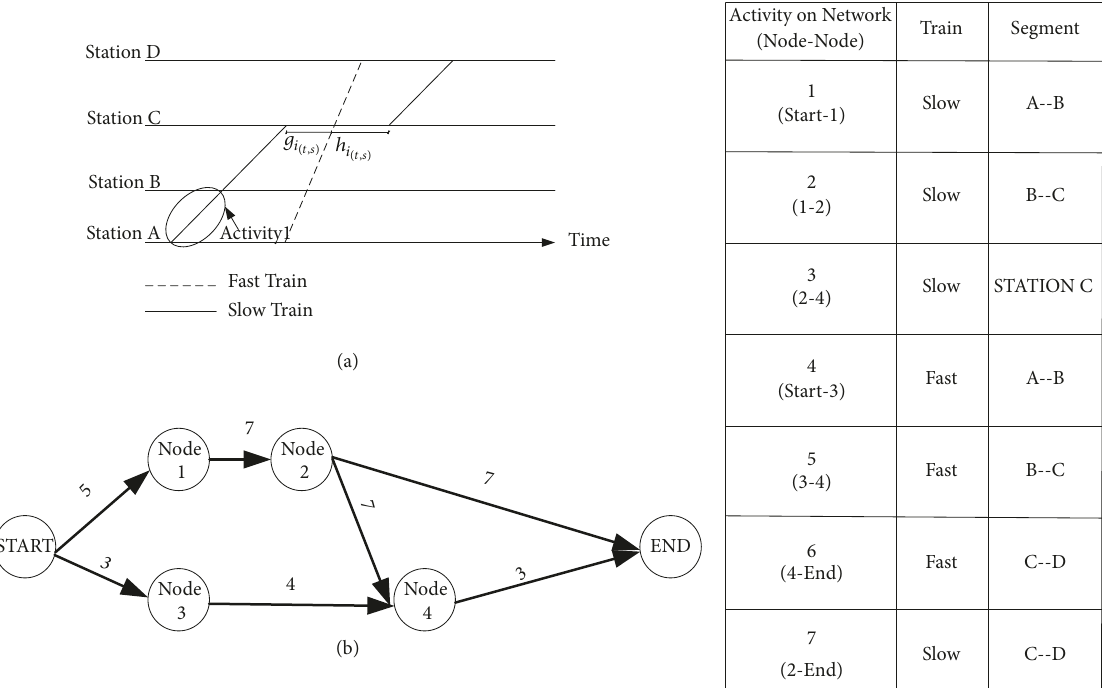
Figure 3: Illustration of conversion of train timetable to DAG and determination of the critical path.